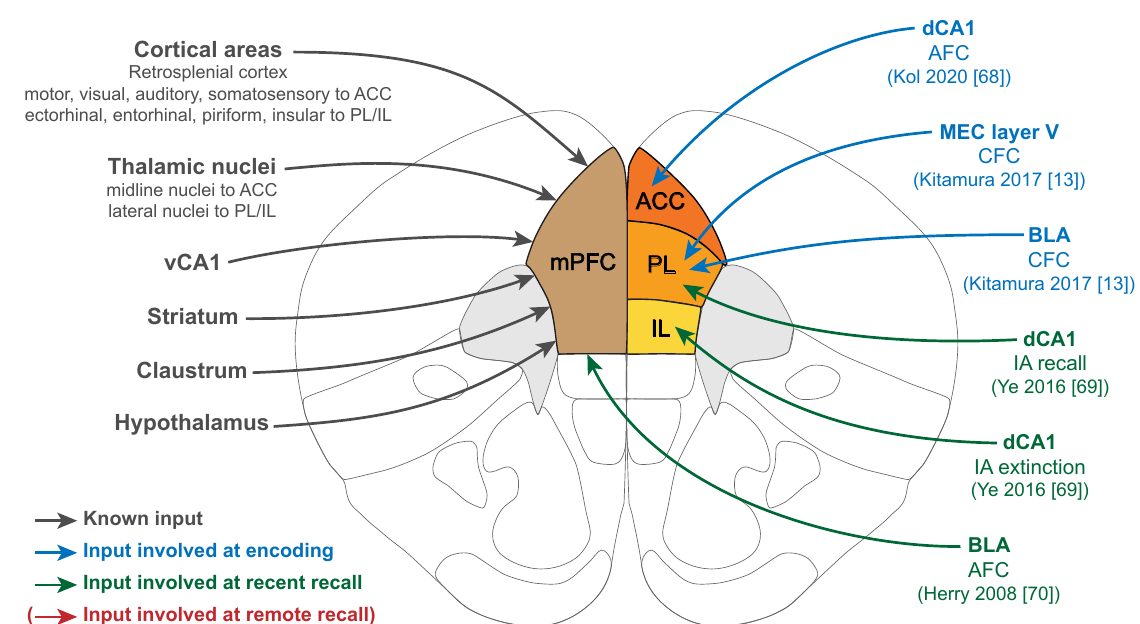
Figure 1. mPFC inputs are involved in encoding and recent recall of fear memories. Left: Anatomically defined inputs to the mPFC. Right: mPFC inputs functionally involved during fear memory consolidation, color coded by the phase of the memory (blue: encoding, green: recent recall, red: remote recall). Note the absence of functionally characterized mPFC inputs at the time of remote recall. AFC: Auditory fear conditioning; CFC: Contextual fear conditioning; IA: Inhibitory avoidance; MEC: Medial entorhinal cortex; BLA: Basolateral amygdala.